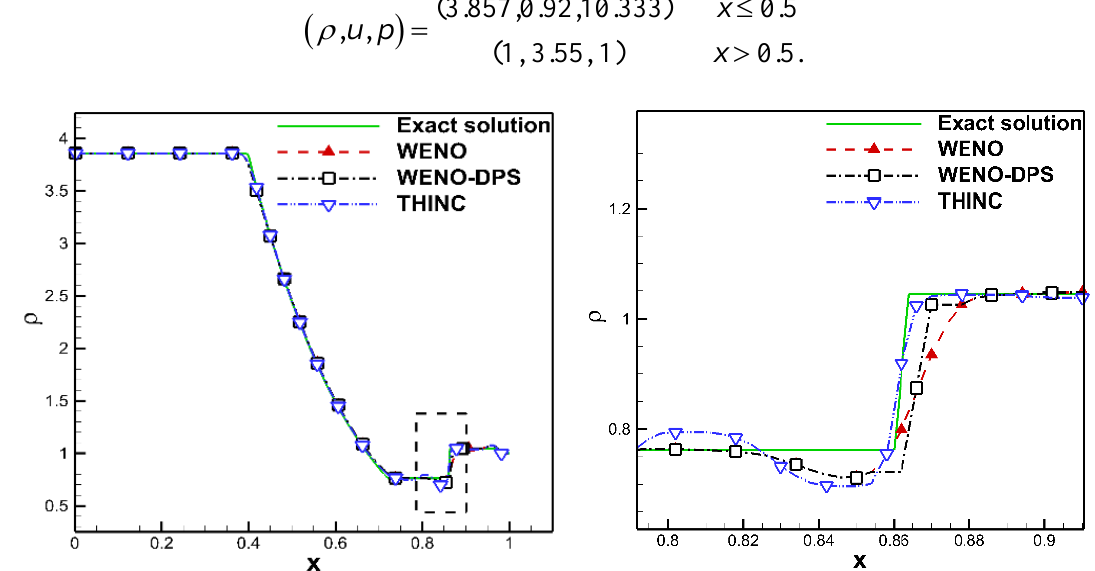
Figure 5. Density plot of Mach 3 test case Figure 6. Zoomed view of the density